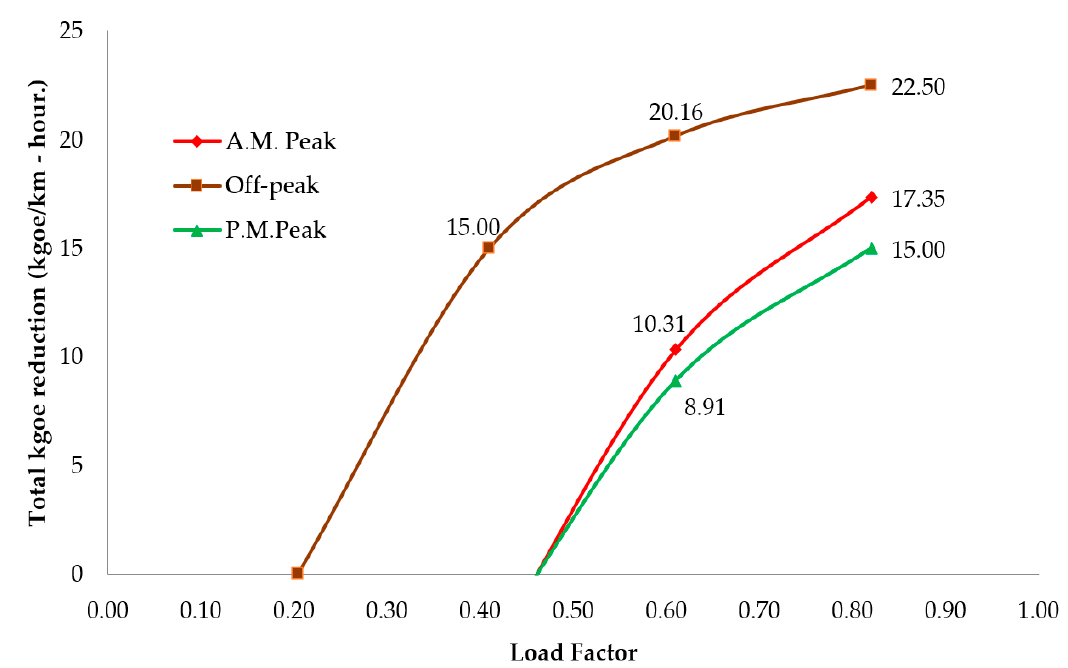
Figure 7. The Relationship between a Kilogram of Oil Equivalent Reduction (kgoe/km-hour) and Load Factor (LF) by Time Period.